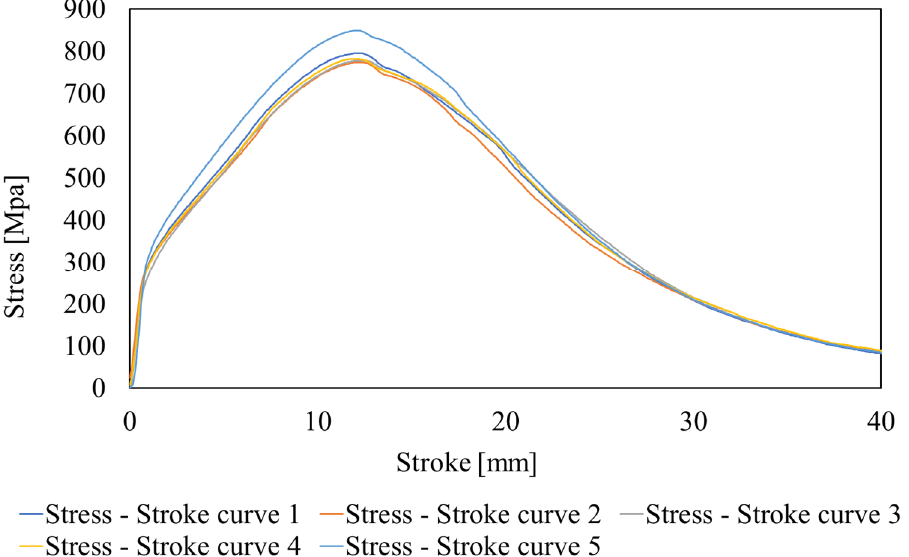
Figure 5. Bending stress–stroke curves.